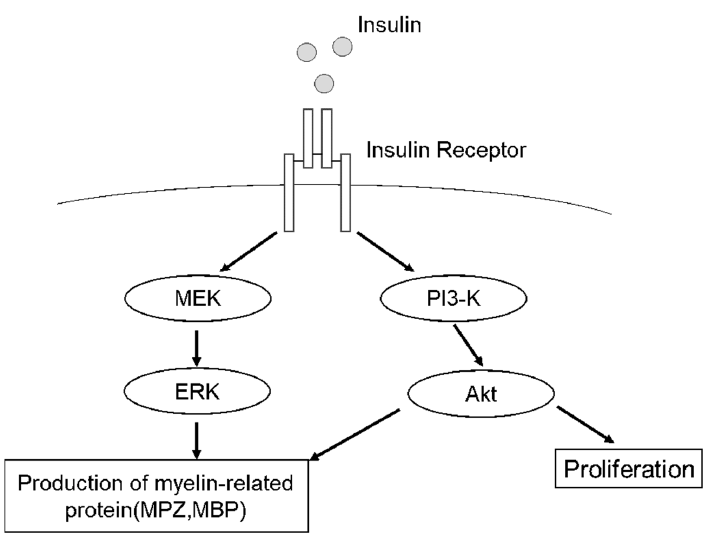
Figure 6. Proposed scheme for insulin-stimulated signaling of the proliferation and the production of myelin-related proteins. Insulin promotes the MPZ expression of IFRS1 via MEK/ERK and MBP expression of PI3-K/Akt, whereas insulin promotes the proliferation of IFRS1 via PI3-K/Akt.